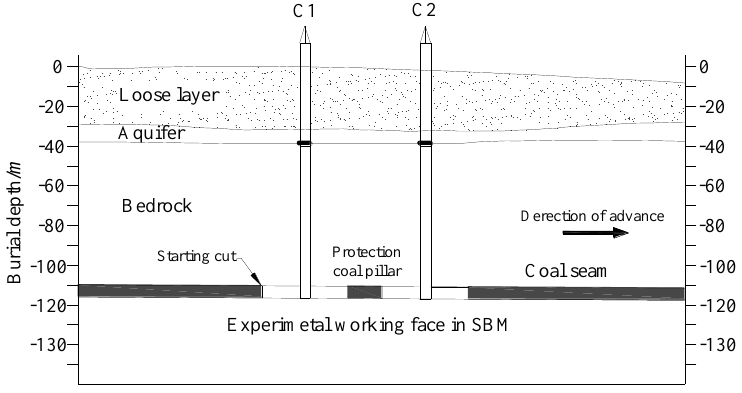
Figure 11. Arrangement of the aquifer and the holes.